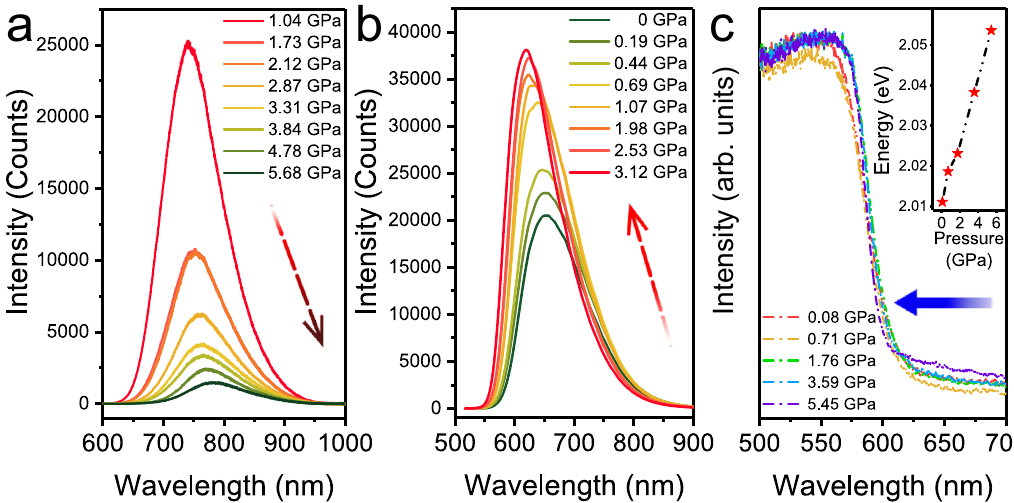
Fig. 2 PL and absorption spectra. a PL spectra of PTCs upon compression up to 5.68 GPa. b PL spectra of PTCs – THF up to 3.12 GPa. c In situ UV – Vis absorption spectra of PTCs – THF up to 5.45 GPa. The inset shows the corresponding pressure dependence of the bandgap. The laser powers for the PL measurements of PTCs and PTCs – THF were 17.19 μ W and 0.068 μ W,